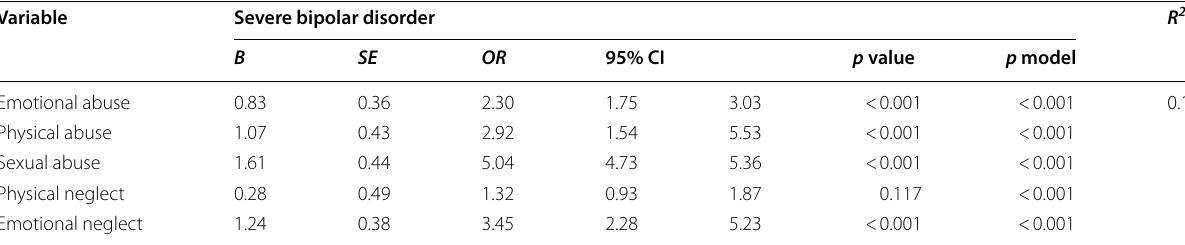
A robust logistic regression model clustered by case–control groups and adjusted by age, gender, marital status, socioeconomic status B regression coefficient, SE Standard Error, OR Odds Ratio, CI Confidence Interval, R 2 Adjusted R‑Squared